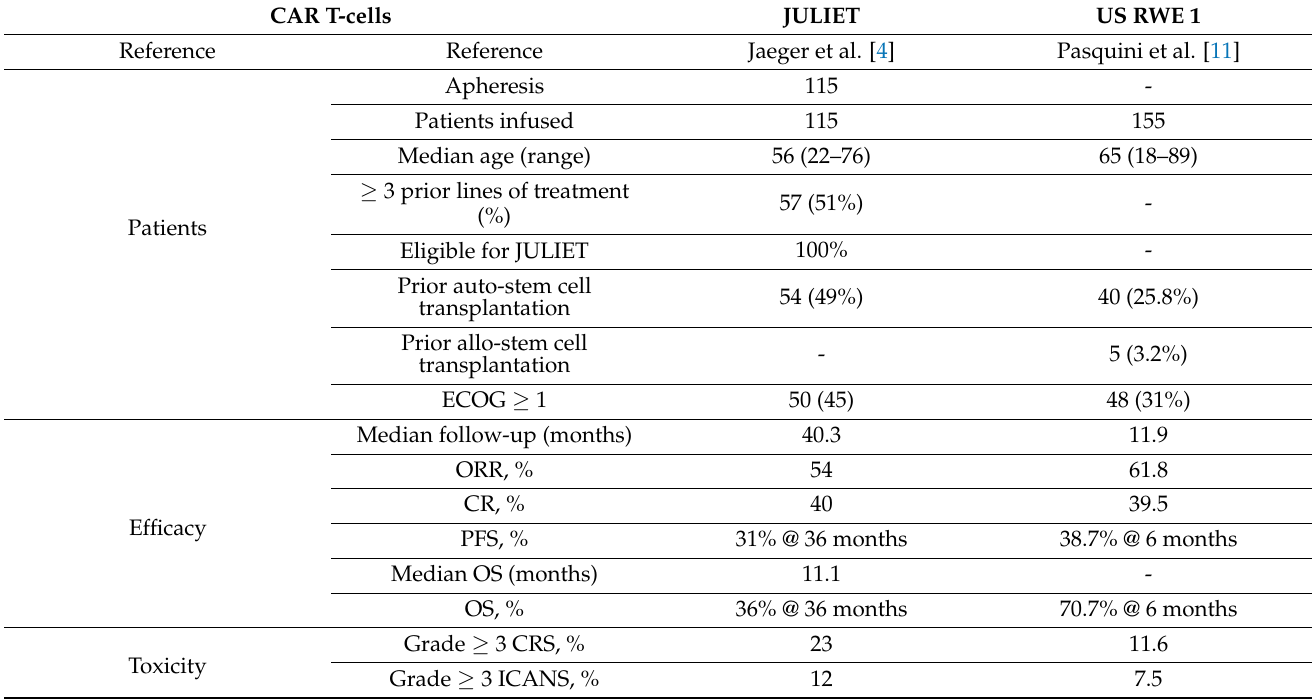
Table 4. Tisa-cel (Kymriah ® ): JULIET vs. Real-World Experience. CAR